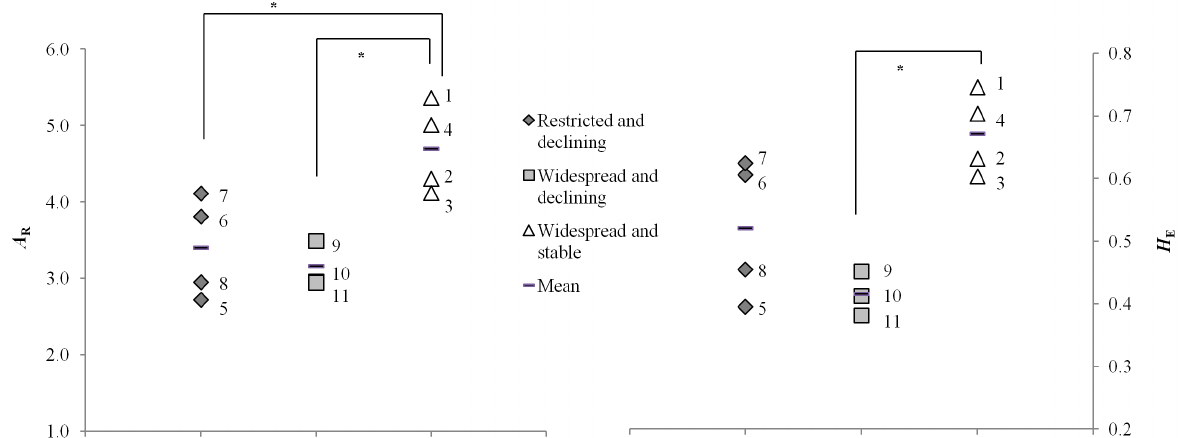
Fig 3. Historical genetic diversity of declining versus stable bumblebee species. Comparison of the mean allelic richness ( A R ) and expected heterozygosity ( H E ) averaged across loci between the populations of the declining and more stable Bombus species within the time period 1918 – 1926. With indication of the significance level, * = P < 0.05